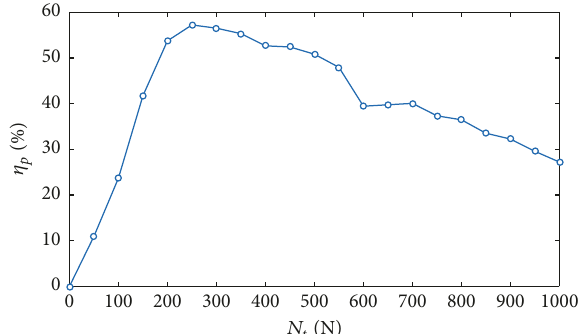
Figure 7: Relationship between the control force 𝑁 𝑡 and the peak vibration-reduction ratio 𝜂 𝑝 .